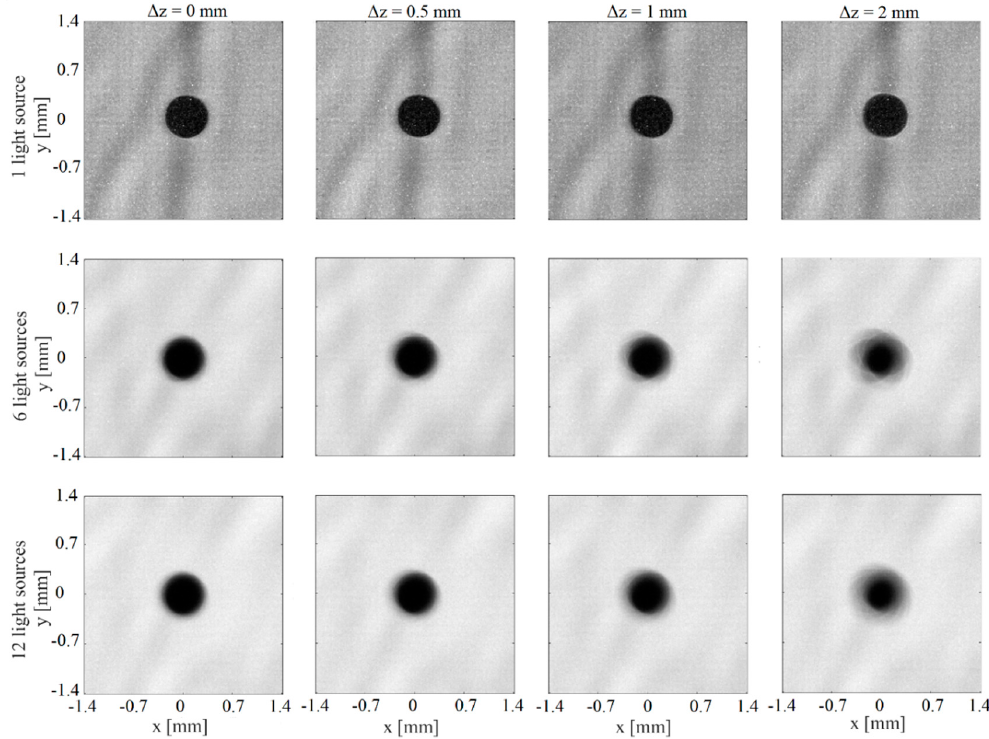
Figure 3. Focusing effect of a dot of a calibration slide. Top images: one source. Middle images: six sources. Bottom images: twelve sources. The images are registered moving the calibration slide away from the camera.